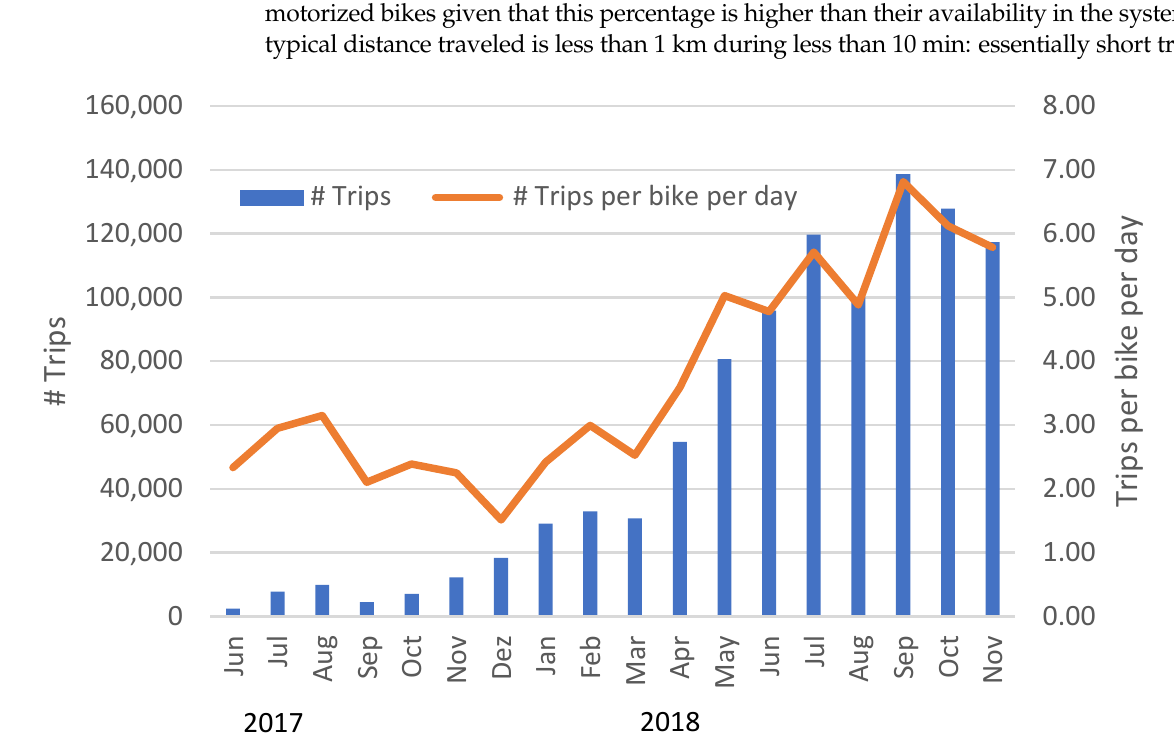
Figure 7. GIRA trips and average trips per bike in the implementation year, 2017, and first year of operation, 2018.